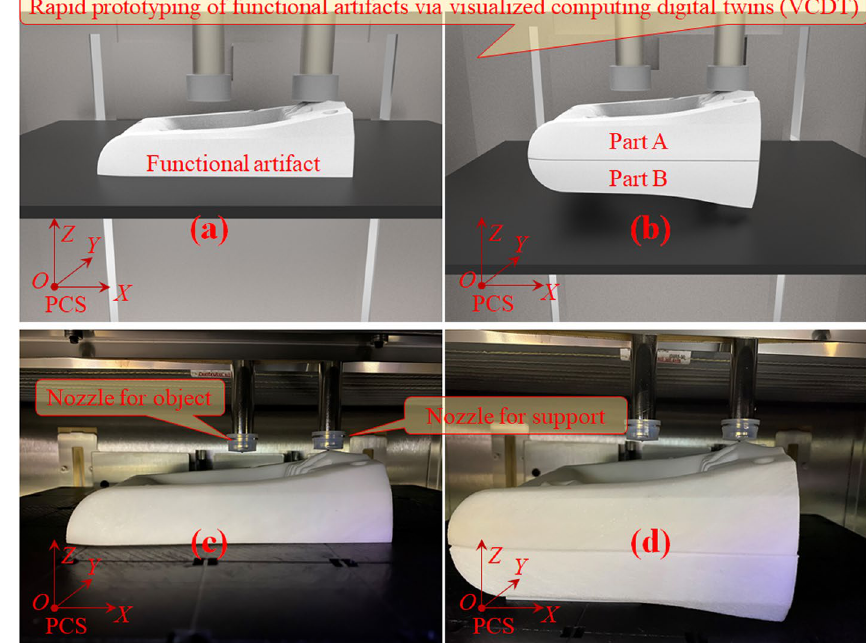
Fig. 13 VCDT of RP where a and b depict the digitally fabricated functional artifacts and c and d display the physical extrusion-based equipment and functional artifacts